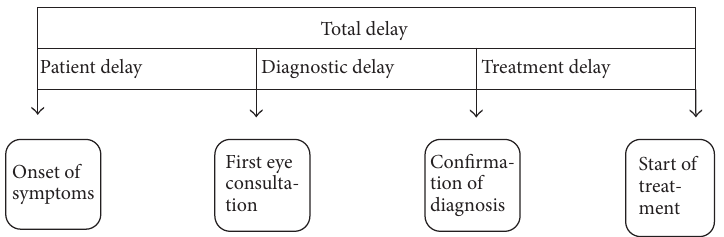
Figure 1: Conceptual diagram on the definition of delays, adapted from Yimer et al. [7].